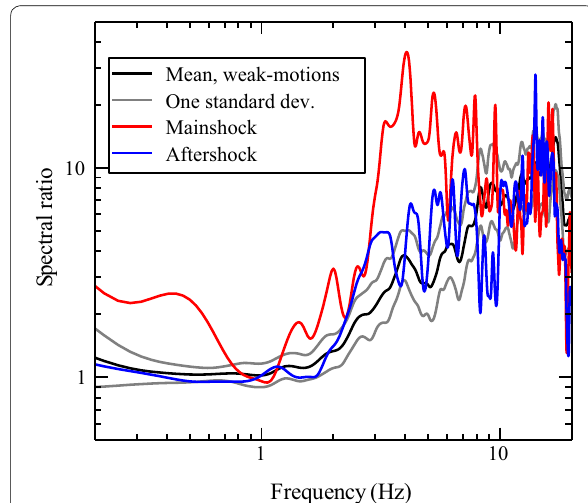
the site IWTH25 were approximately 465 and 1073 m/s, Fig. 10 Comparison of surface-to-borehole spectral ratios of vertical component acceleration recordings (V-to-V) at site IBUH01 during weak-motions (mean of the weak-motions, black line), that showed asymmetric waves were relatively stiff sites. mainshock (red line), and an aftershock (blue line). The gray lines denote the range of plus–minus one standard deviation from the mean of weak-motion spectral ratios. The aftershock (Mj 5.4, focal = depth 40 km, epicentral distance 24.3 km, back azimuth 142.6°) = = = occurred on September 6, 2018, at 06:11 JST, about 3 h later than the